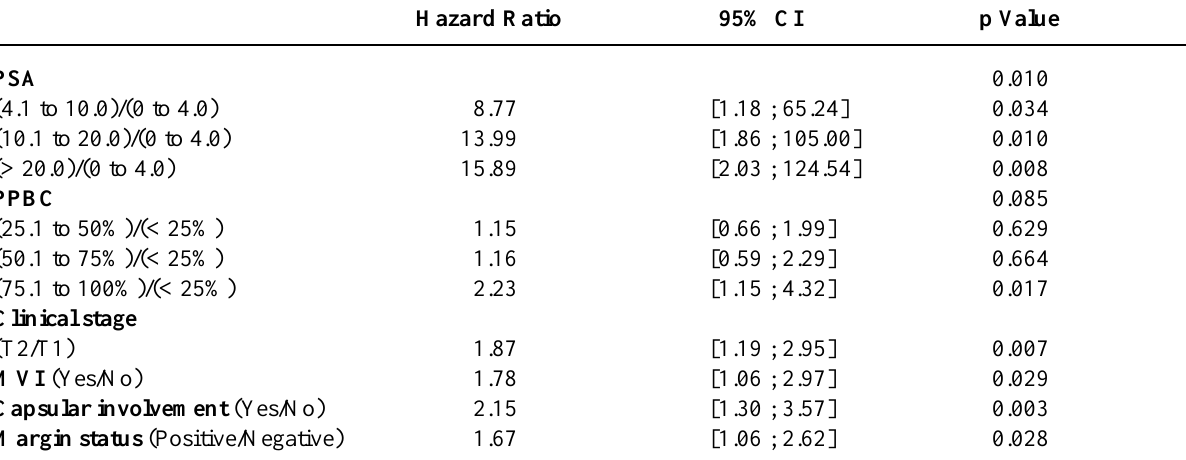
Table 4 – Cox regression for the risk of biochemical recurrence (multivariate